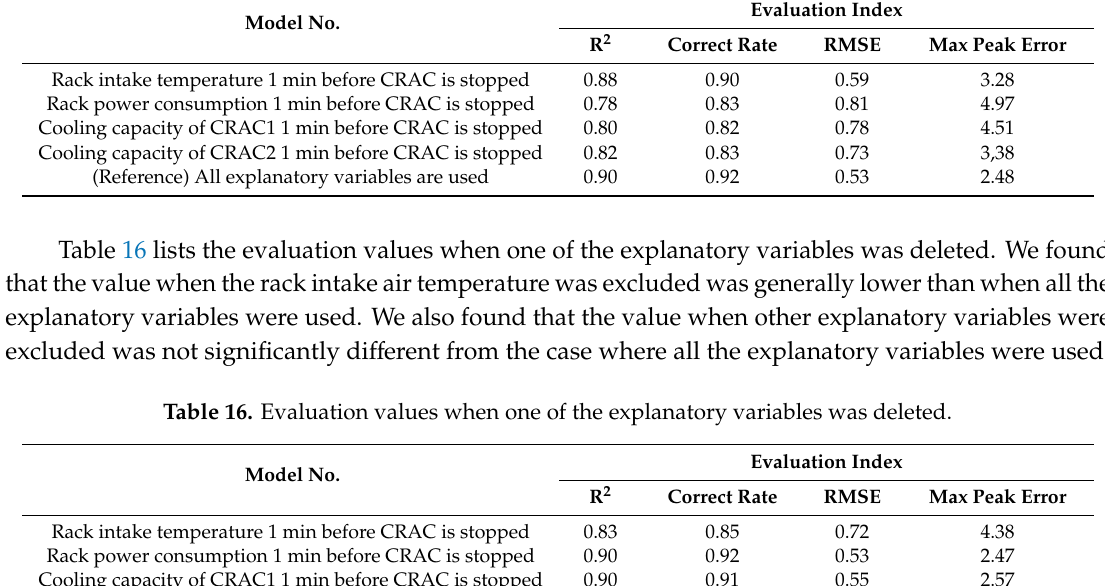
Table 15. Evaluation index values when only one of the explanatory variables is used. Model No.